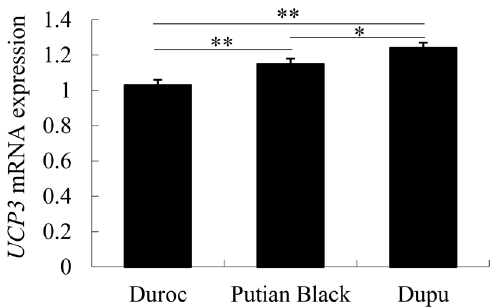
Figure 4. Differentiation of UCP3 mRNA expression in skeletal muscle between different pig breeds. Values are means with their standard errors. Significant differences between breeds are denoted by * p< 0.05), ** p<0.01. UCP3, uncoupling protein